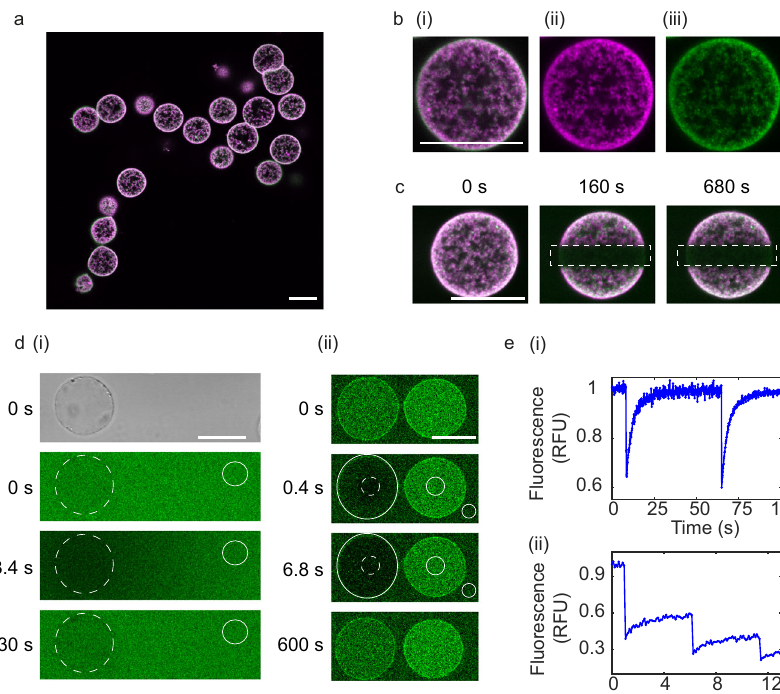
Fig. 2 Fluorescence confocal microscopy of proteinosomes. a Dual colour fl uorescence confocal images of proteinosomes containing template DNA (protein conjugate labelled with fl uorescein isothiocyanate (FITC) and DNA complex labelled with carboxy-X-rhodamine (ROX), b Zoom in of single proteinosome from: (i) Dual colour fl uorescence, (ii) Single colour fl uorescence channel, DNA labelled with ROX, (iii) protein conjugate labelled with FITC. All scale bars are 25 μ m. c Fluorescent confocal microscopy images of photobleaching experiments, output frames for dual fl uorescence confocal images of DNA-biotin-streptavidin complex labelled with ROX and protein conjugate labelled with FITC at t = 0 s (before bleaching), t = 160 s (after bleaching) and t = 680 s (after bleaching). Dotted rectangles show the region of photobleaching. All scale bars are 25 μ m. Data are representative from at least 10 repeats. d Characterisation of the permeability of DNA (i) and PEN enzymes (ii) into proteinosomes. d (i) Bright- fi eld image ( t = 0 s) used to locate proteinosomes at t = 0 s. Output frames from Fluorescence Recovery after Photobleaching (FRAP) experiments of (i) single-stranded DNA (labelled with DY530) at t = 0 s (before photobleaching), t = 8.4 s (immediately after photobleaching) and t = 30 s (after recovery). Representation from two repeats. Scale bars are 20 μ m. (ii) Polymerase enzyme tagged with FITC. Output frames at t = 0 s (before photobleaching), t = 0.4 s and t = 6.8 s and t = 600 s (after recovery). Scale bar is 20 μ m. Dotted circle indicates bleached spot and the non-dotted circles show backgrounds used for normalisation from a single experiment. e FRAP analysis of (i) single-stranded DNA (ii) polymerase. Source data are provided in the source data fi le.